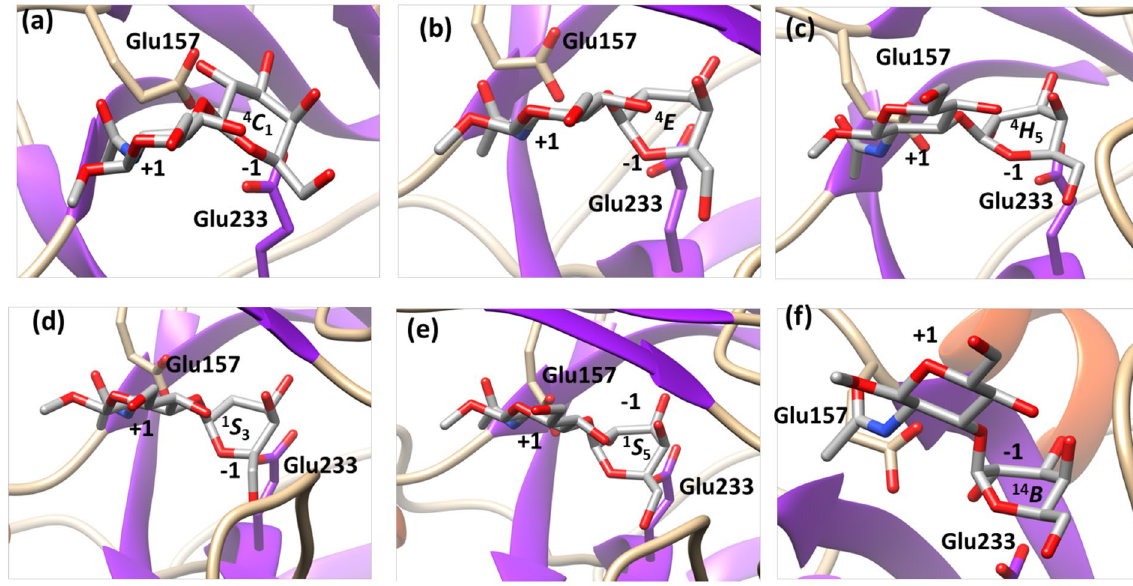
Figure 4. Puckering changes observed at subsite − 1 during MD simulations in family GH35. Selected conformational states at subsite − 1 of β -1,3-LacNAc-OMe = DGalpb1–3DGlcNAcp-OMe during MD analysis (GH35, PDB ID: